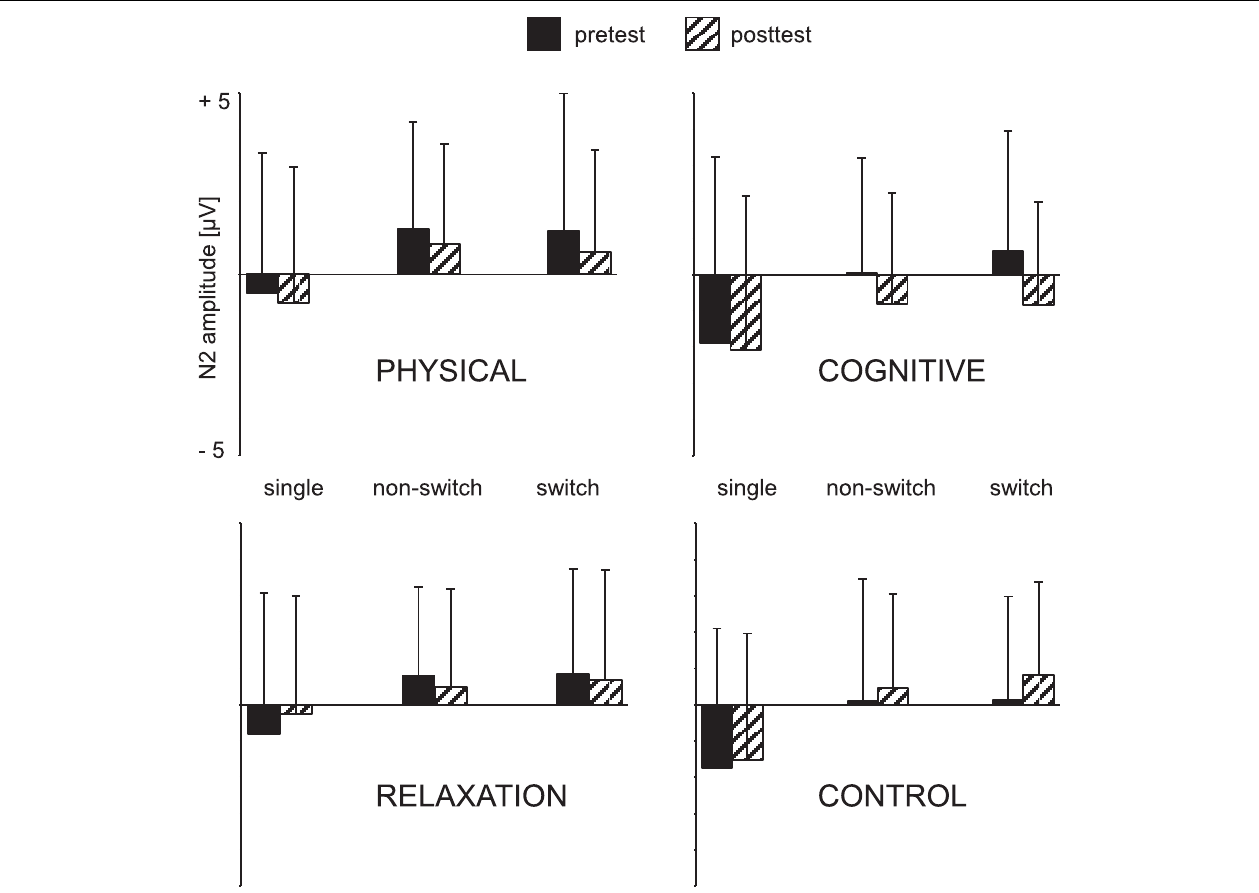
FIGURE 4 | Mean peak amplitudes of the N2 at Cz as a function of the trial type (single task, non-switch and switch trials), session (pre vs. post) and group. The error bars reflect standard deviation (SD).